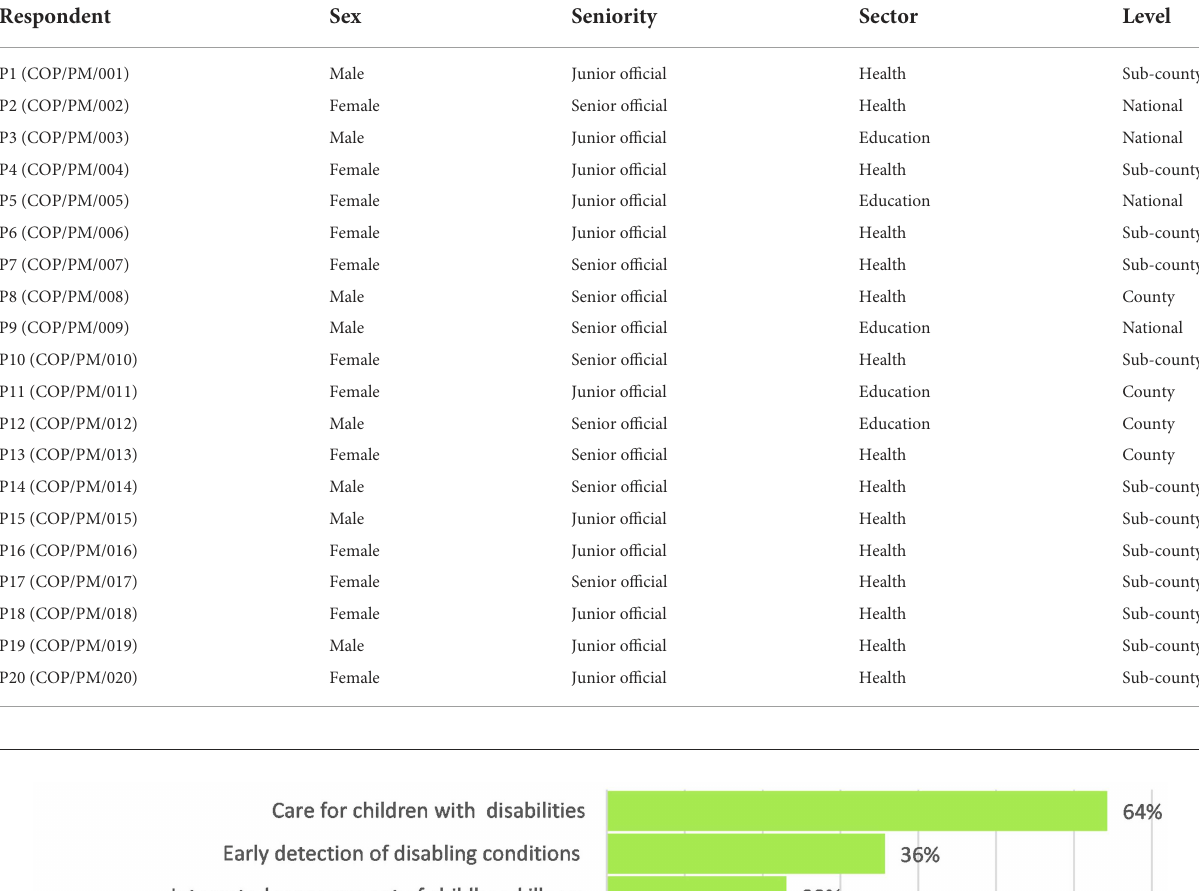
TABLE 4 Qualitative interview participant characteristics.